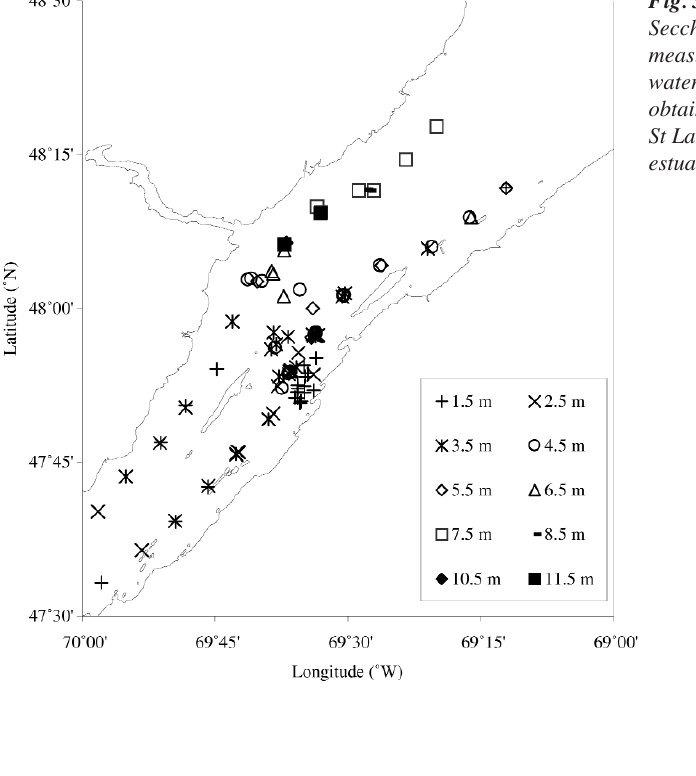
Fig. 4. Visibility of models of adult and juvenile belugas related to their depth of immersion and to the turbidity of the